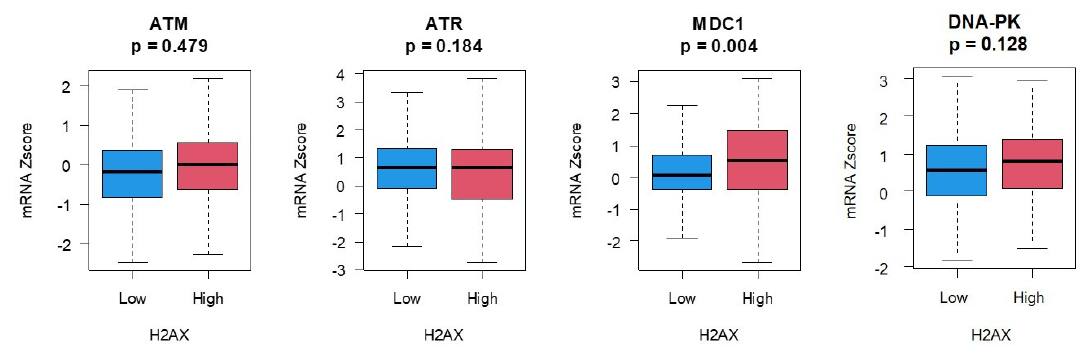
Figure 5. Differential expression of 4 key genes that alter the H2AX phosphorylation status in response to DSBs upon stratification of ovarian cancer patients to low- and high-expressing H2AX groups. Only Mediator of DNA Damage Checkpoint 1 (MDC1) was significantly upregulated in the high- H2AX expressing group.